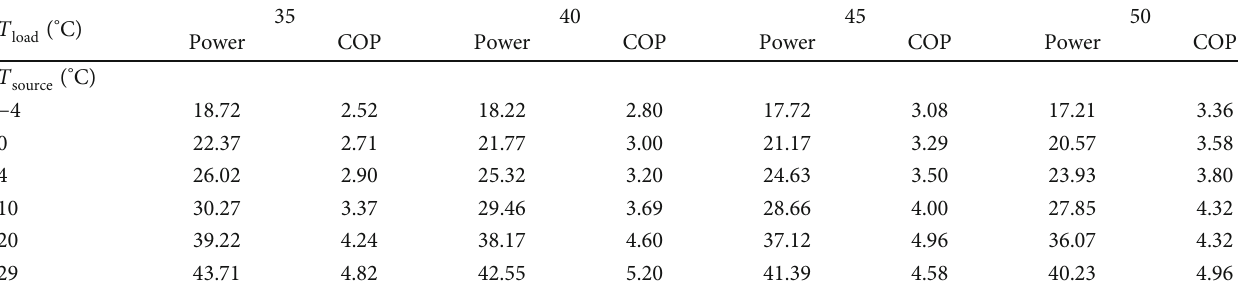
(b) Heating characteristics of the heat pump